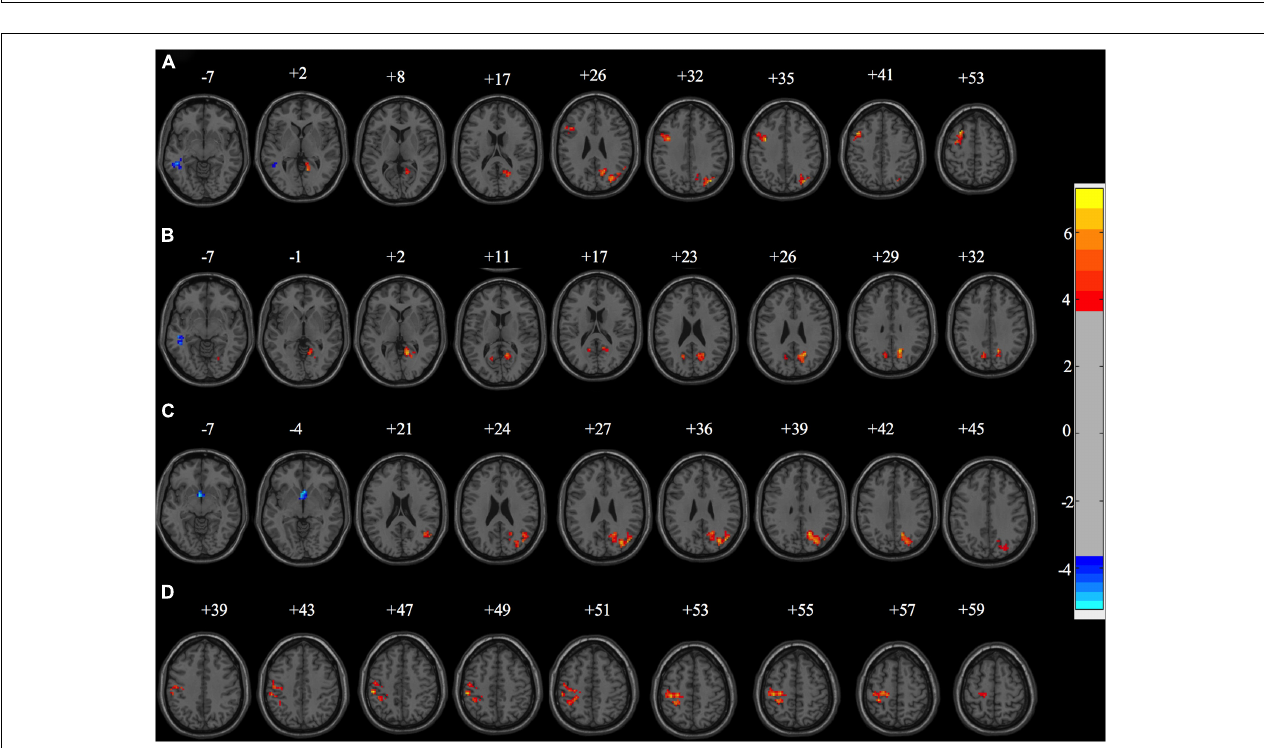
FIGURE 2 | Comparison amounts of the PD + VDD, PD + VDD, and PD + NVD patients and the health control group with Bonferroni correction; (A) comparison of education in PD patients and healthy controls; (B) comparison of MMSE scores in PD patients and healthy controls. # P = 0.029, ∗ P < 0.001; PD + VDD, PD patients with VD deficiency; PD + VDI, D patients with VD insufficiency; PD + NVD, PD patients with normal VD levels; MMSE, Mini-Mental State Examination.